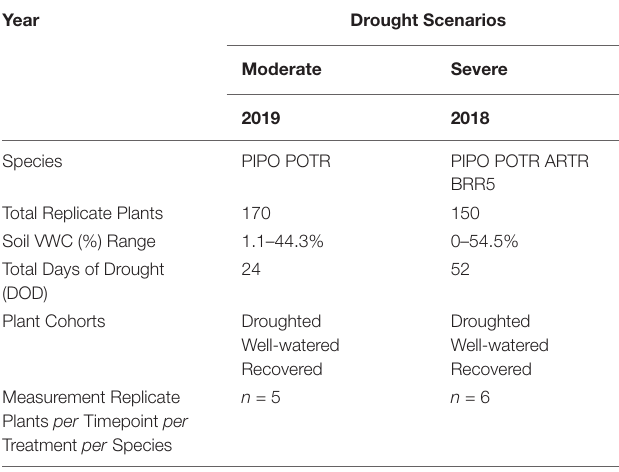
TABLE 2 | Describing moderate (2019) and severe (2018) drought scenarios and the associated species, number of replicants, days of drought, cohorts, and time point